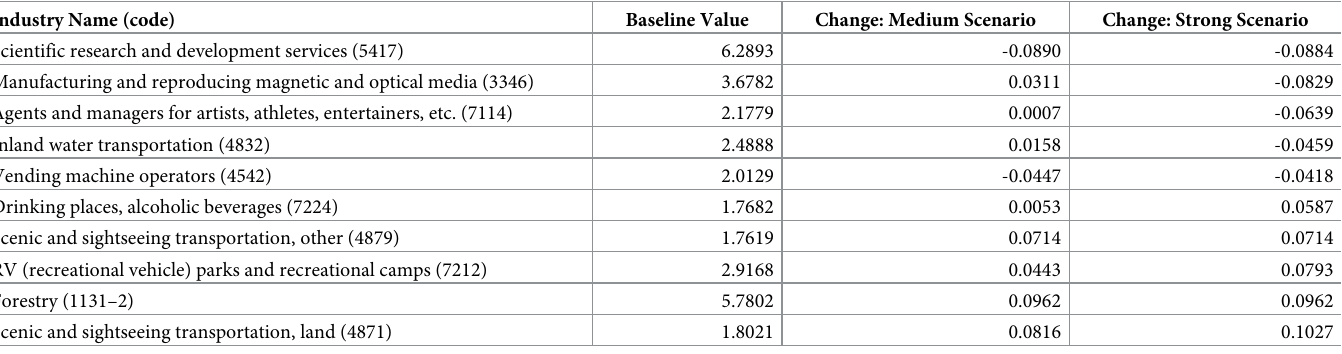
Table 9. Projected changes in social IWAs per worker– 4-digit industries.